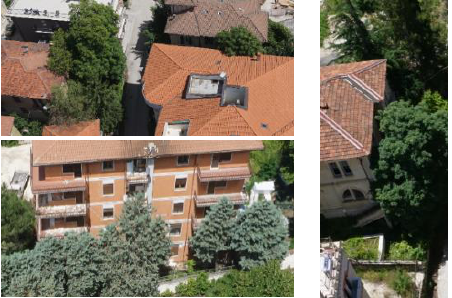
Figure 1 Three examples of vegetation occlusion in the UAV multi-view L'Aquila dataset